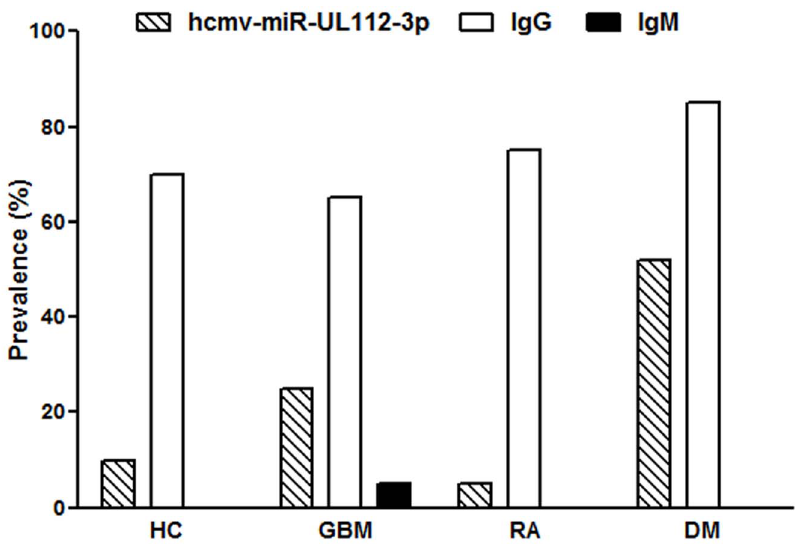
Figure 4. The prevalence of hcmv-miR-UL112-3p was determined using a TaqMan miRNA assay, and the seroprevalence of IgG and IgM against HCMV was detected with ELISA assays in all patients and controls. HC 5 Healthy Controls, GBM 5 Glioblastoma multiforme, RA 5 Rheumatoid Arthritis and DM 5 Diabetes Mellitus (patients from the DIGAMI-2 cohort).